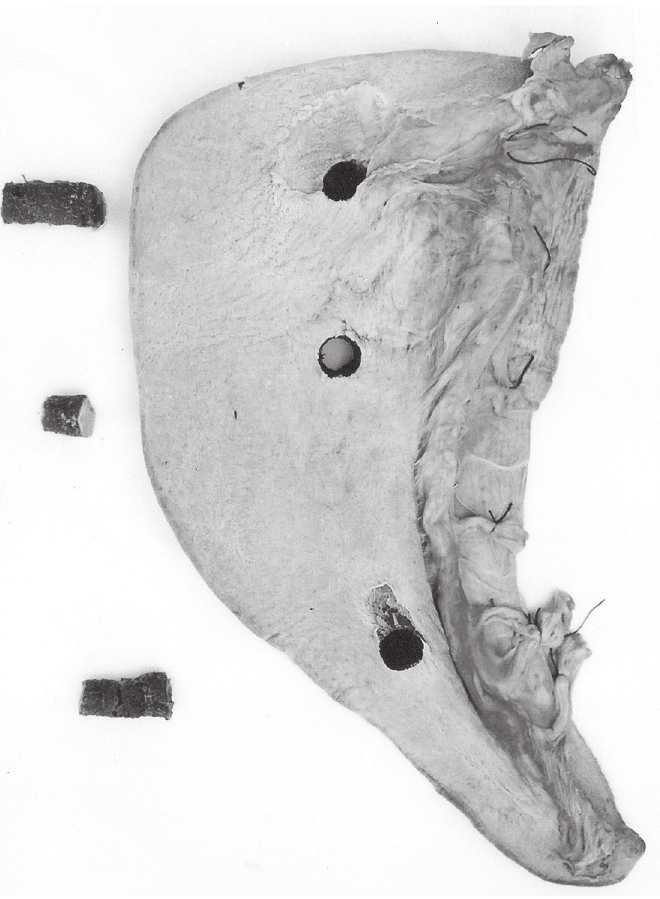
Figure 1 - Macroscopic view of spleen visceral face showing the location of withdrawal of fragments and the lower thickness in concave